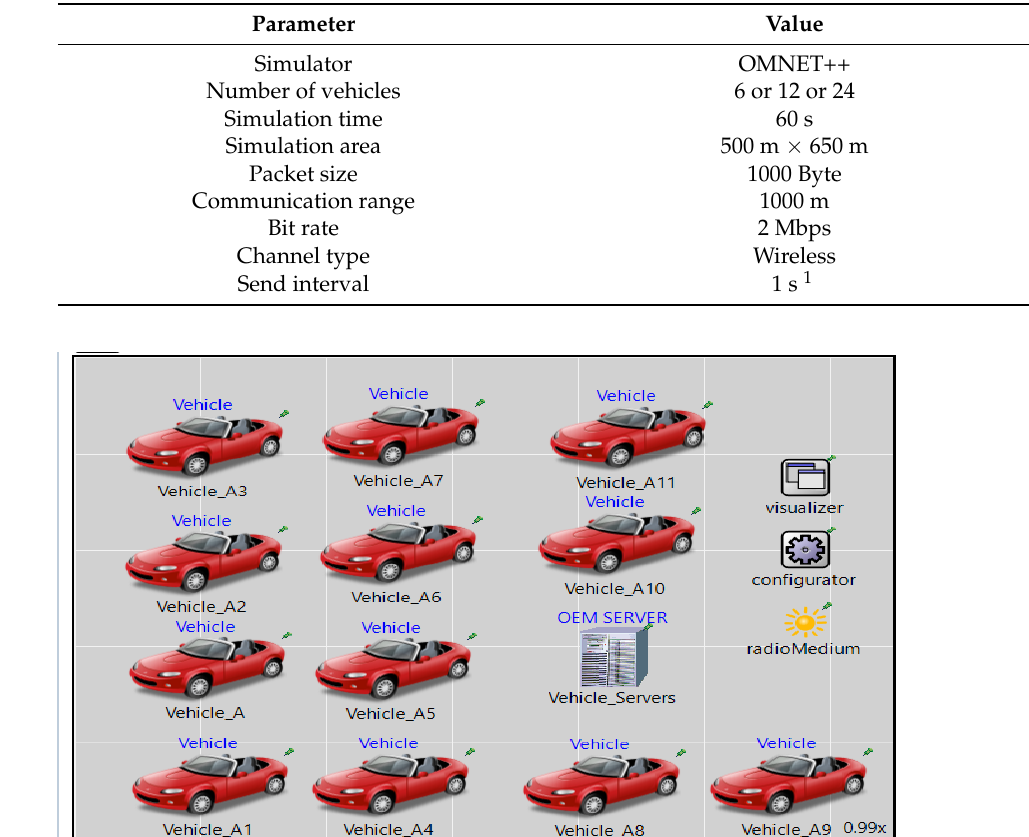
Figure 18. Full setup for 12 vehicles sending 1000 bytes to the OEM